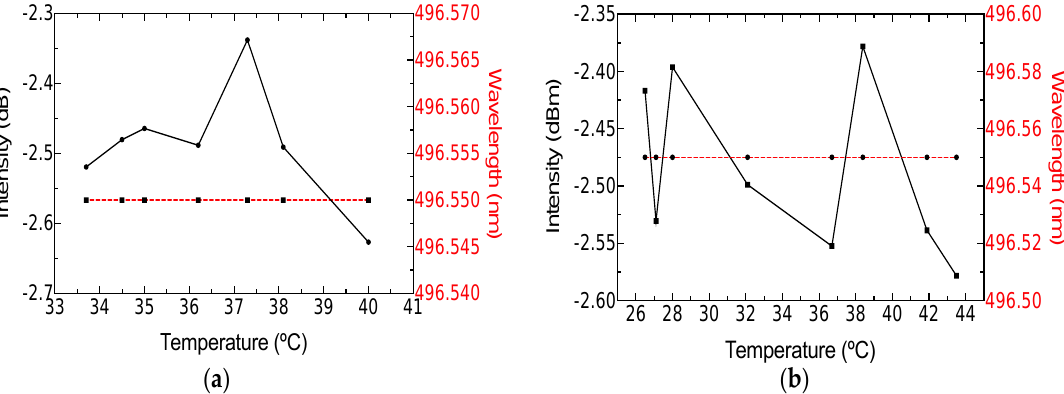
Figure 10. Power and wavelength response for optimal peak wavelength operation when ( a ) milk temperature and ( b ) external temperature were modified.